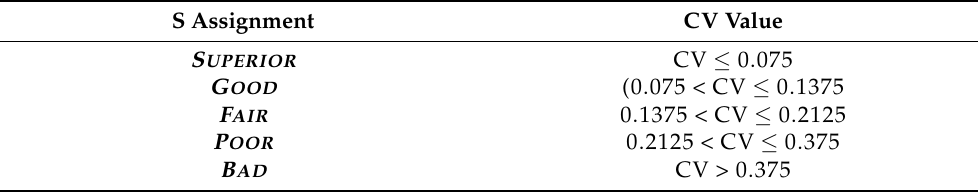
Table 14. Assignment matrix for the uncertainty assessment of a specific CV value, termed S. These assignments will be used in Section 5.2. These were determined as one-half the Table 2 limit values for the qualitative